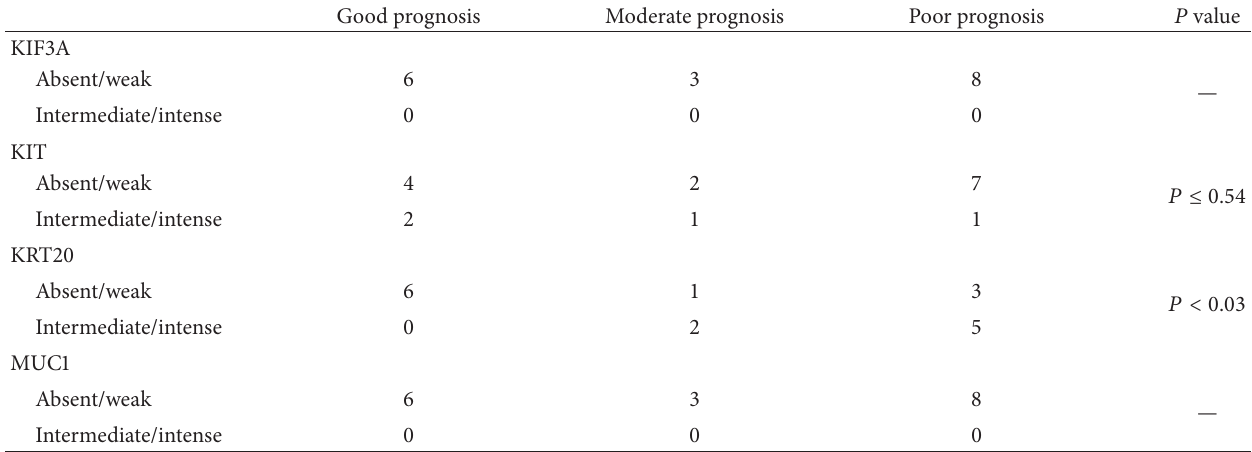
Table3:ImmunohistochemistryresultsforKIF3A,KIT,KRT20,andMUC1.Resultsweregroupedintoabsent/weakandintermediate/intense staining. Fisher’s exact probability test compared good and poor prognosis